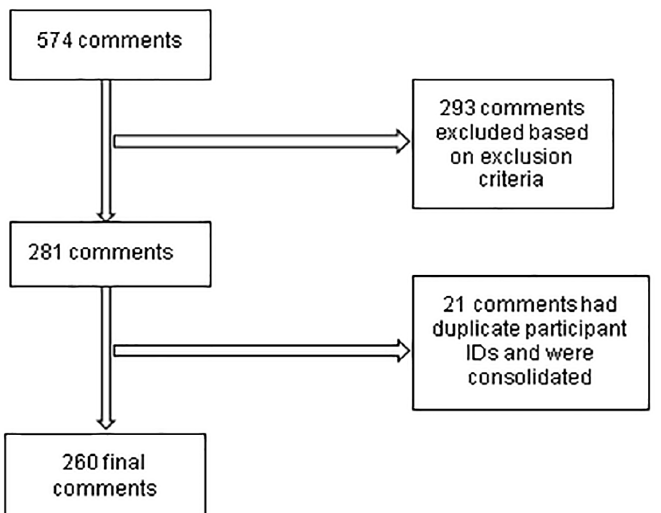
Table 1. Demographic information of multi-site emergency